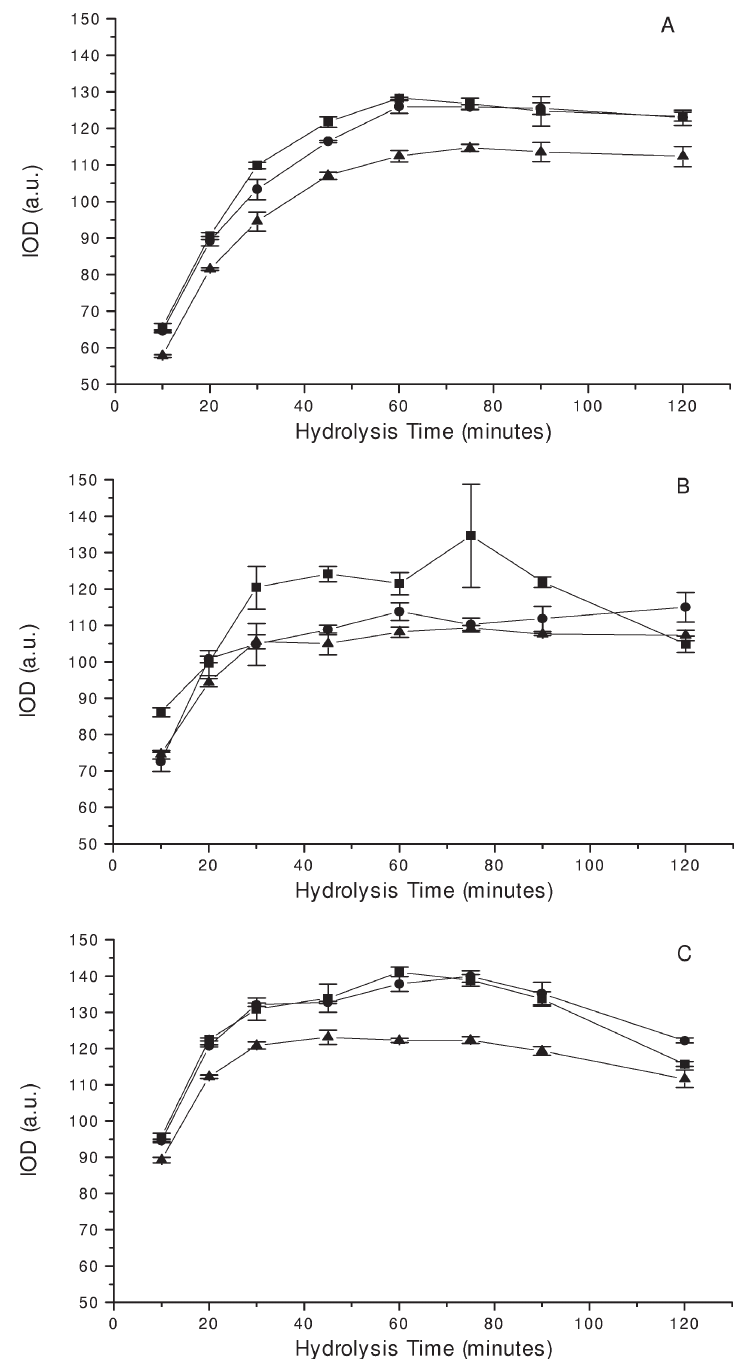
Fig. 1. Hydrolysis curves for lymphatic cells (A), epithelial cells from buccal mucosa (B), uterine myometrial cells (C) fixed by different types of fixatives: (cid:4) – Delaunay, (cid:15) – Saccomanno, N – air-drying with postfixation in modified Böhm–Sprenger